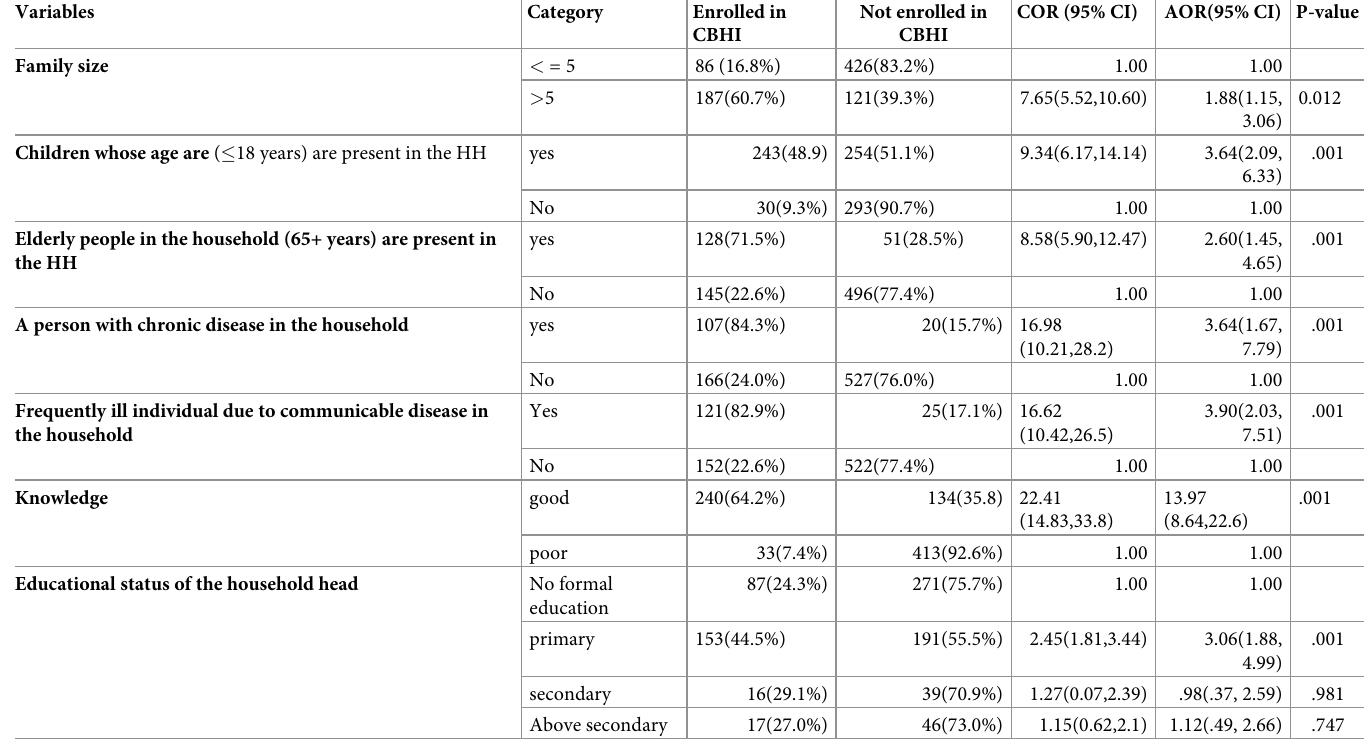
Table 4. Multivariable logistic regression analysis to identify associated factors of CBHI enrollment among households in Segen area and South Omo zones, 27 April to 12 June 2018 (n =